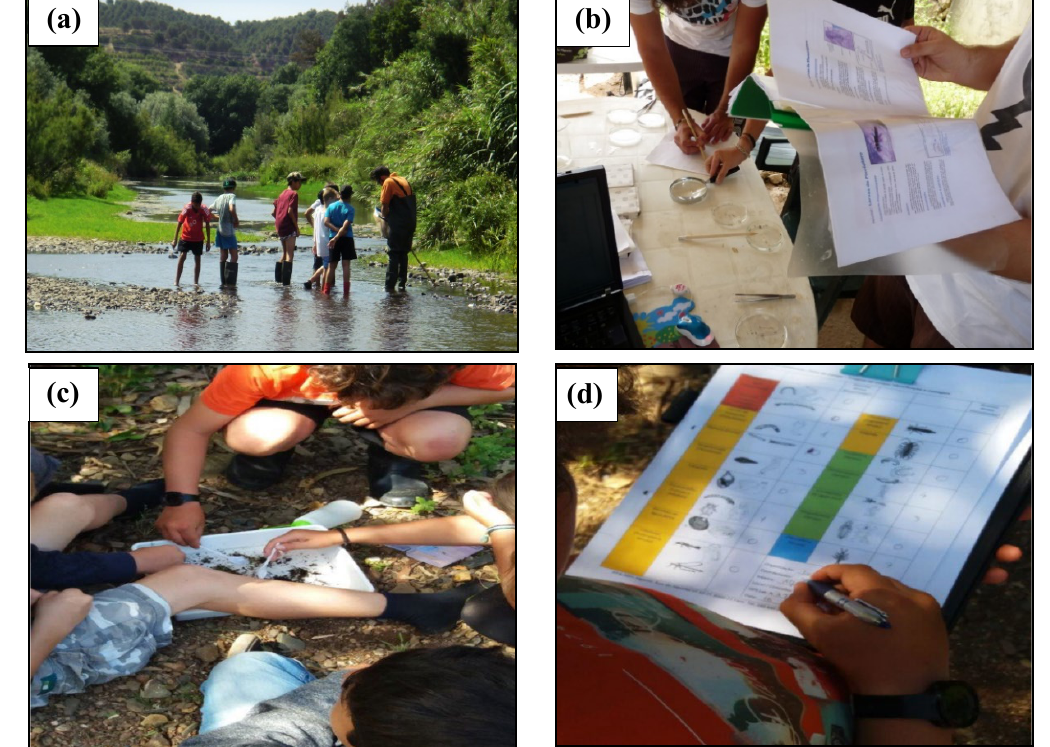
Figure 3. ( a ) Habitat assessment and macroinvertebrate sampling, ( b ) screening, ( c ) identification, and ( d ) classification of macroinvertebrates by volunteers in the Algarve region, southern Portugal.